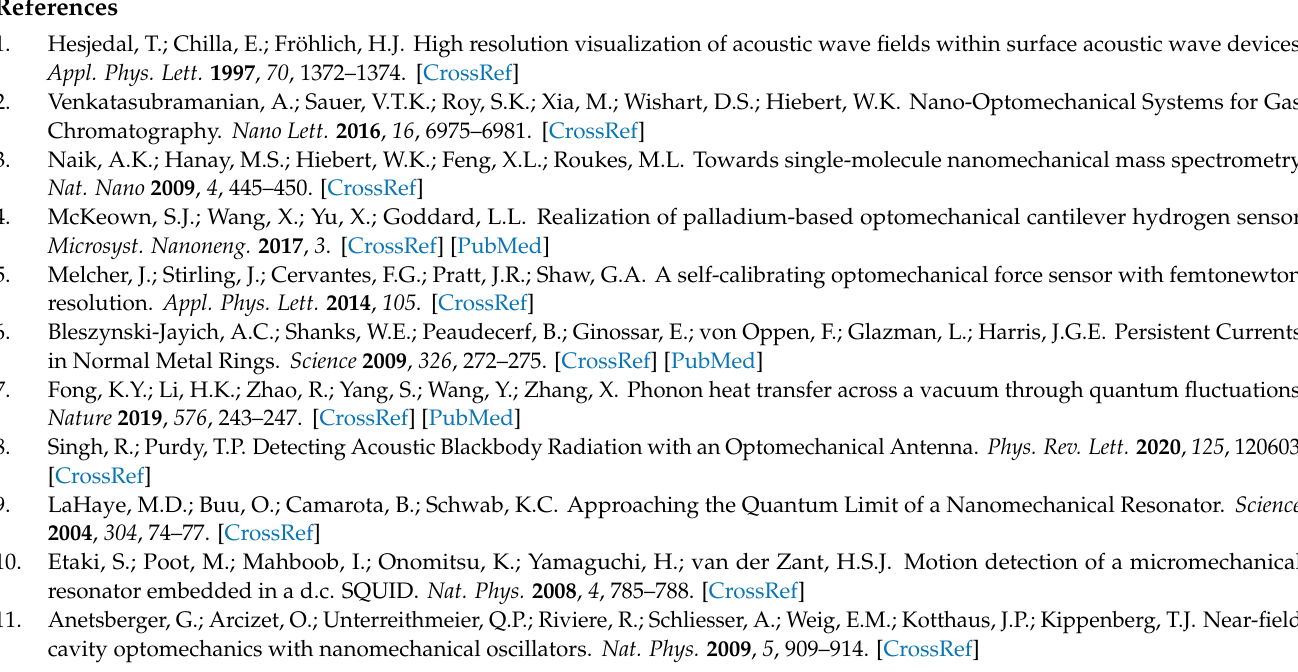
Figure A3. Schematic illustration of the nanofabrication process flow of the sample. ( a ) The sample is diced from a wafer with 330nm Si 3 N 4 on 3300nm SiO 2 on a Si substrate. ( b ) The holes of the membrane are patterned by electron beam lithography. ( c ) The holes are dry etched by reactive ion etching. ( d ) The membrane is released by wet etching with buffered hydrofluoric acid (light blue). ( e ) Under the released membrane a cavity is formed, resulting in the interference utilized for measuring the mode